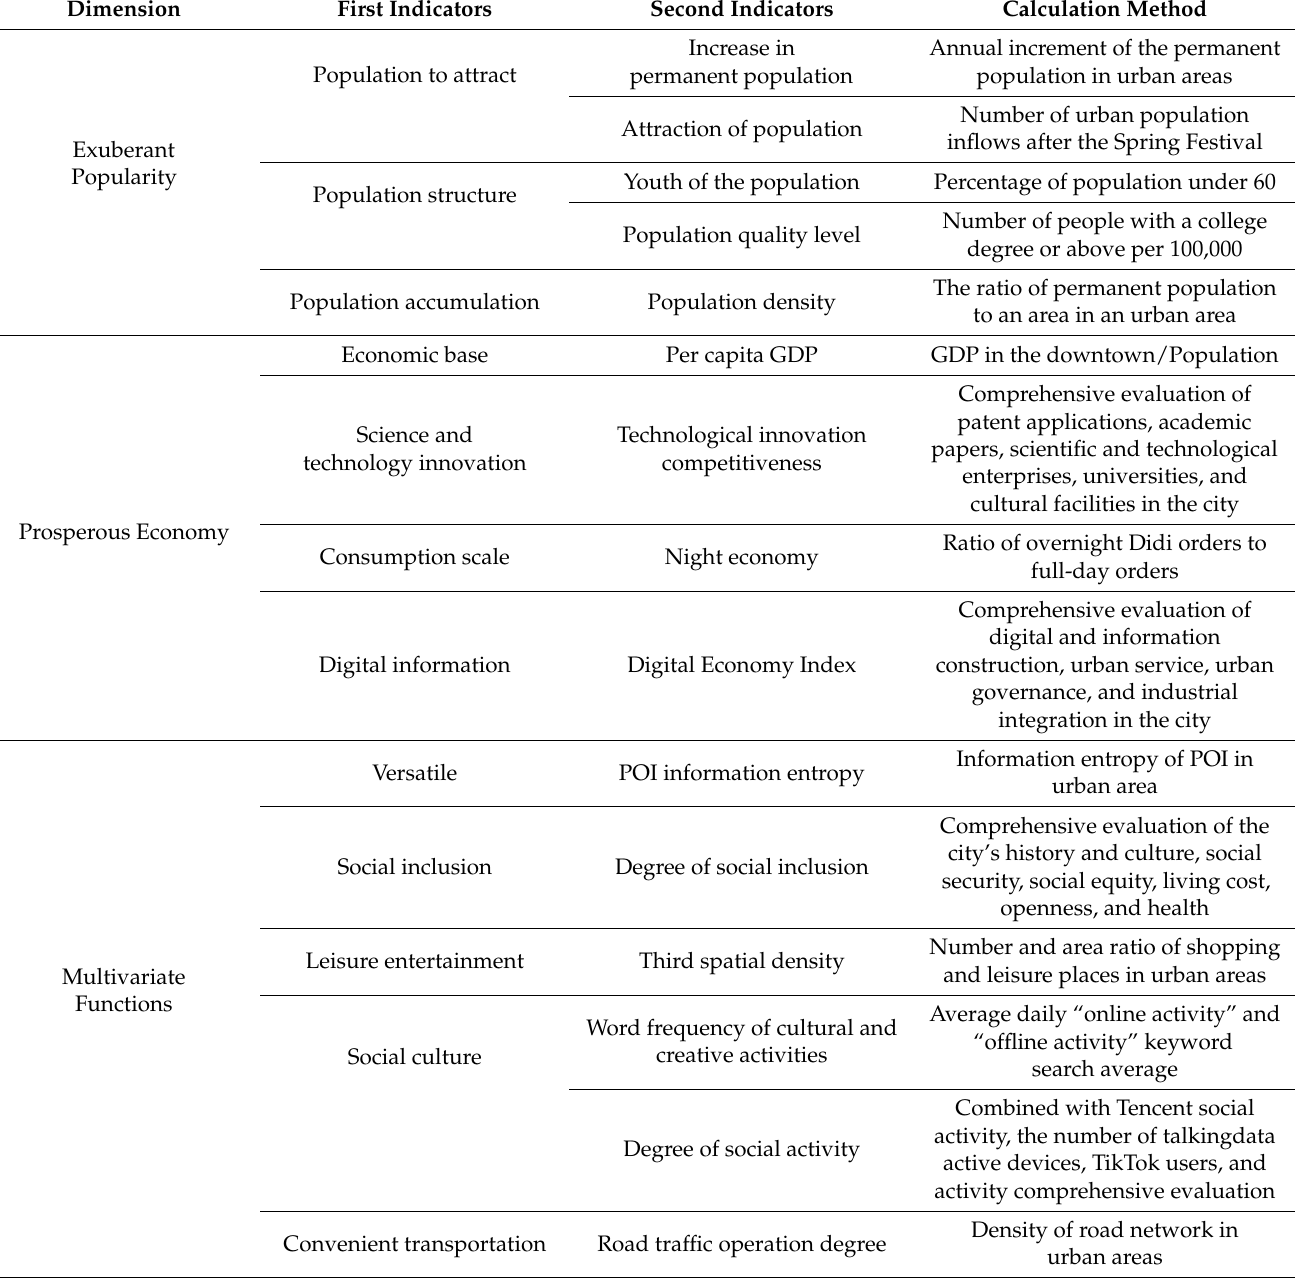
Table 2. Index system of urban vitality at the administrative region